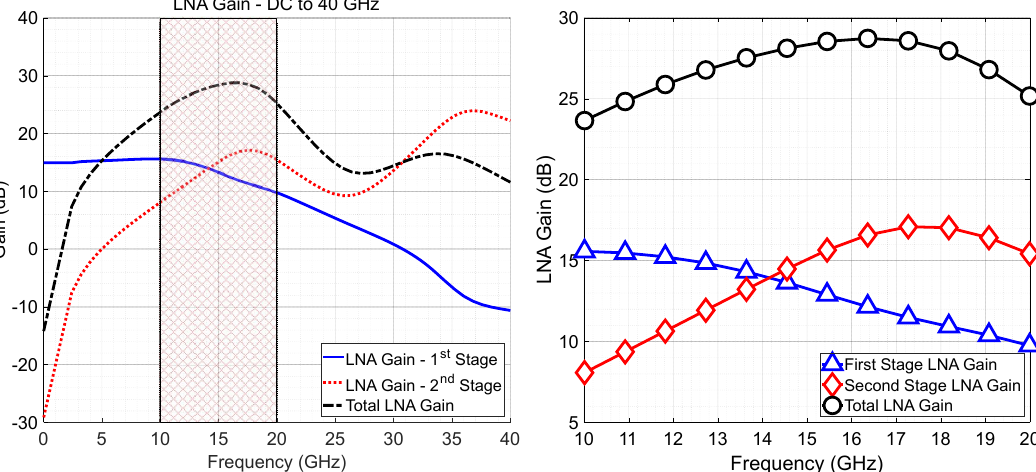
Figure 12. Simulated LNA gain with individual contribution from first and second stages: extending from DC to 40 GHz ( left ); and zoomed-in version from 10 to 20 GHz ( right